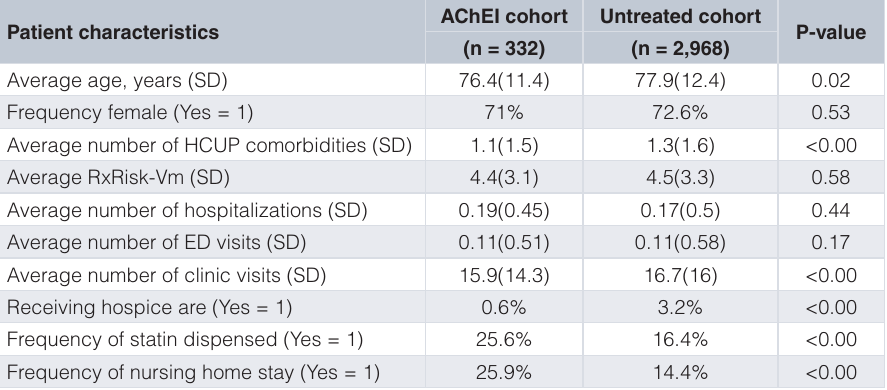
Table 2. Basic characteristics of the study population,